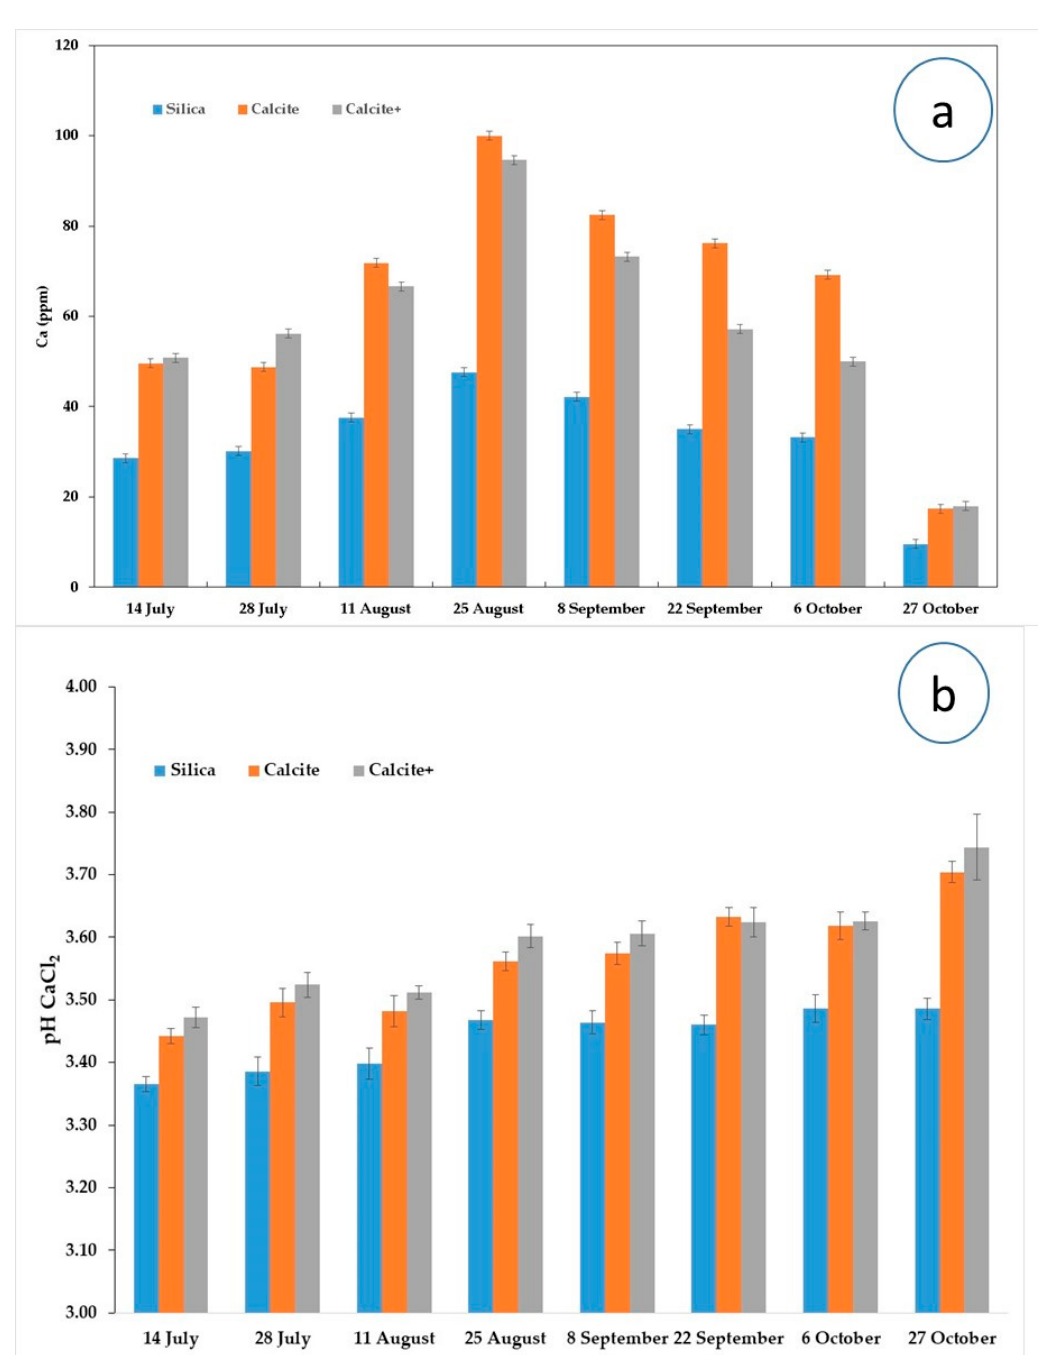
Figure 7. Variations in ( a ) the calcium concentration, and ( b ) the pHCaCl 2 of the growing peat media during the first growing season of white spruce seedlings (1 + 0) depending on the cover material (silica: 29 g/cavity, calcite: 24 g/cavity and calcite+: 31 g/cavity).